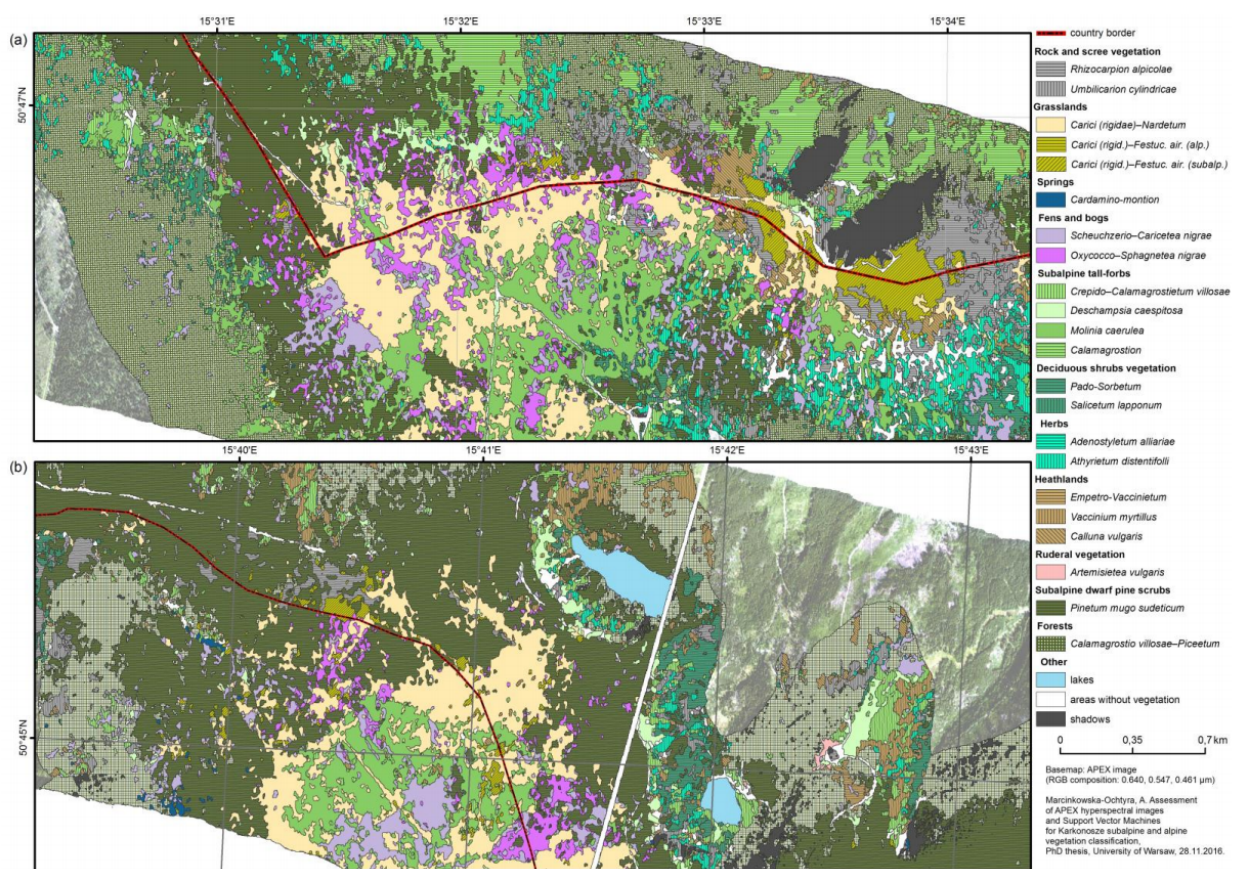
Figure 5. Map of vegetation communities of the Giant Mountains: ( a ) western part, ( b ) eastern part ([58],